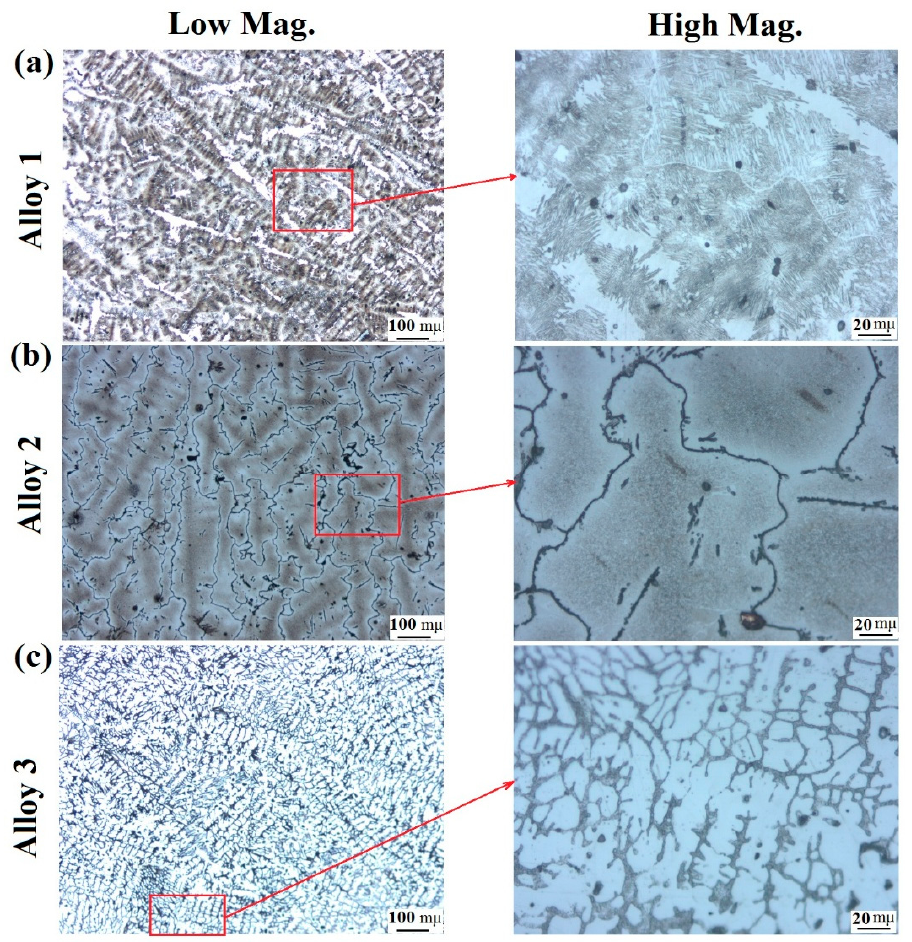
Figure 8. Microstructural images of as-cast HEAs ( a ) Alloy 1, ( b ) Alloy 2, and ( c ) Alloy 3. Low and high magnification are presented in left and right, respectively.